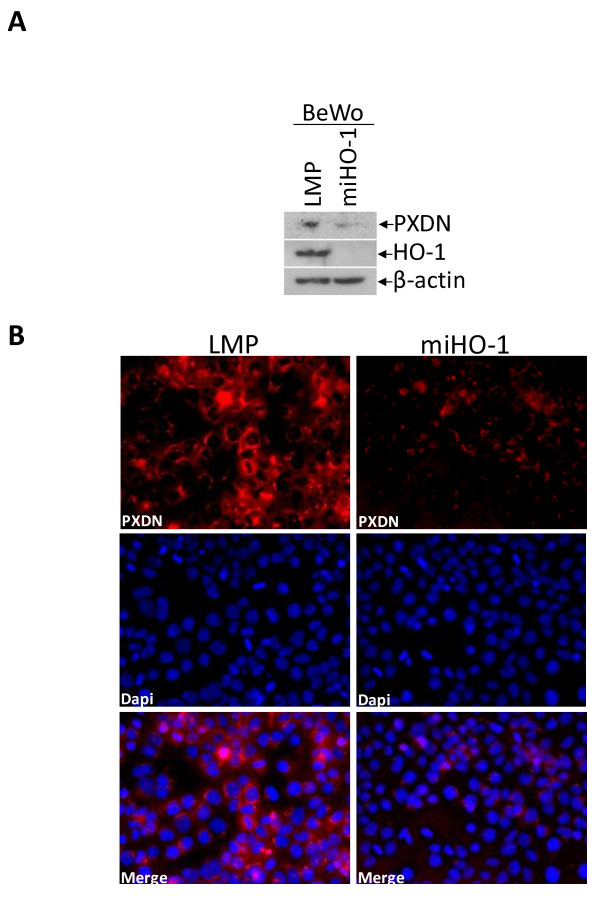
Knock-down of HO-1 in BeWo cells diminishes PXDN protein expression. (A) PXDN detection by western blotting of LMP and miHO-1 BeWo cells. β-actin indicates equal loading. A representative example is shown. (B) Immunofluorescent detection of PXDN (=red) and nuclei (DAPI = blue) in cultured LMP and miHO-1 BeWo cells. Fields shown are representative of each population.